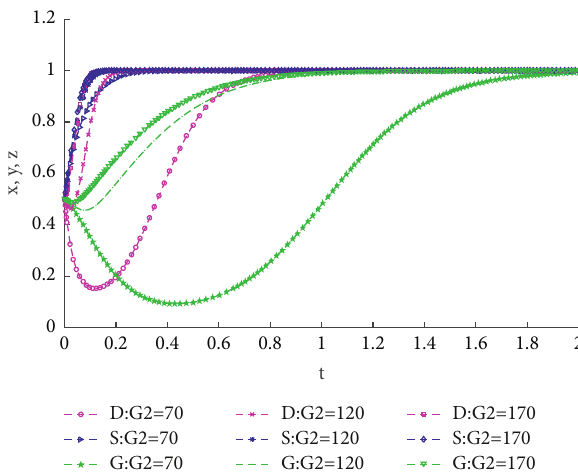
Figure 4: The platform rewards the service demander with the evolutionary result of the